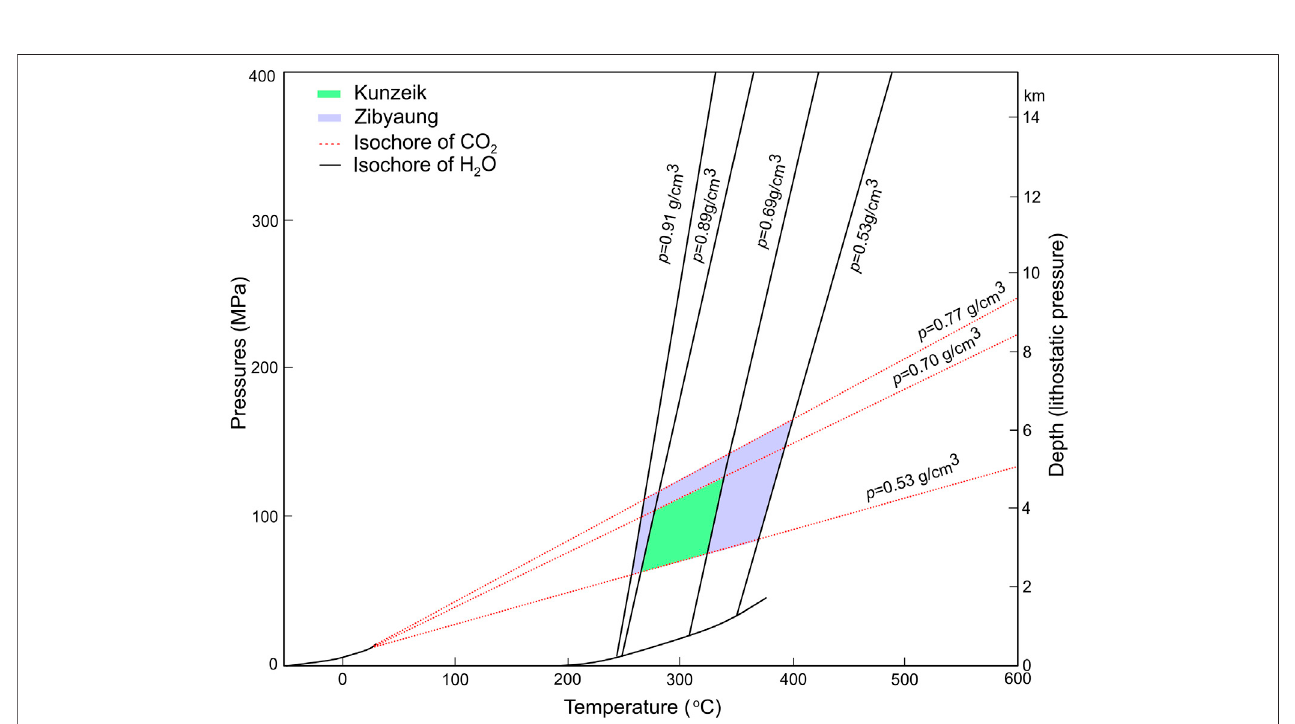
FIGURE15| P-Tdiagram displaying isochoresofthe minimumand maximum densitiesoftwotypes of fl uid inclusions (modi fi ed from Roedder and Bodnar, 1980; Bowers and Helgeson, 1983). Figure indicates the density values (in g/cm 3 ) for respective inclusions. P-T estimation by intersecting isochores of Type A (aqueous- carbonic) (dashed lines) and Type B (aqueous) (solid lines) inclusions.